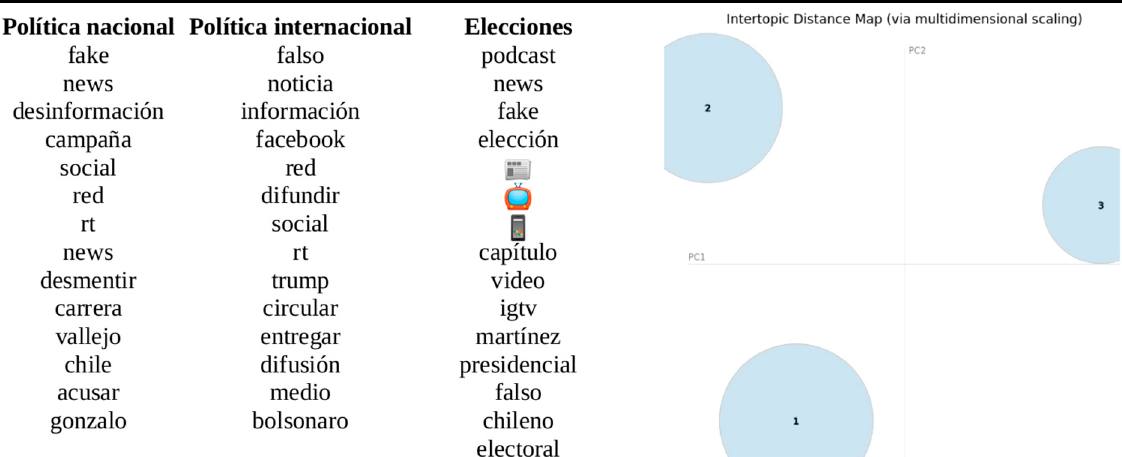
Figure 4. Top words and projection in the main foreground of the three topics obtained with LDA.